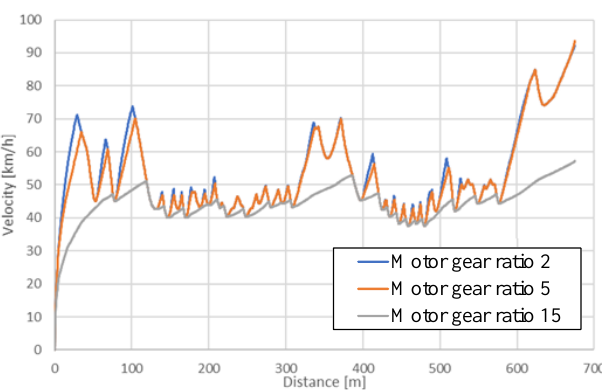
Figure 15. Relationship between distance and vehicle velocity for each electric motor gear ratio.